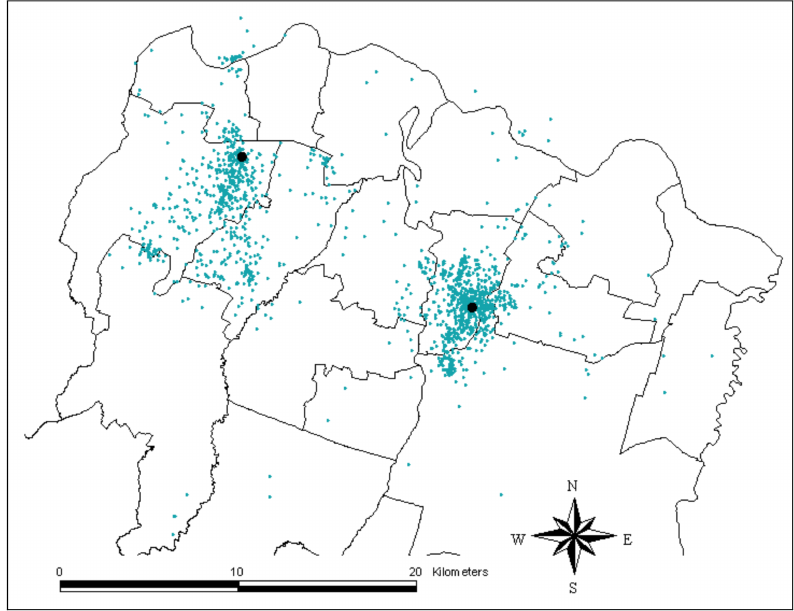
Figure 2. The subset of 1936 GPS points depicting the tracked red-footed falcons in